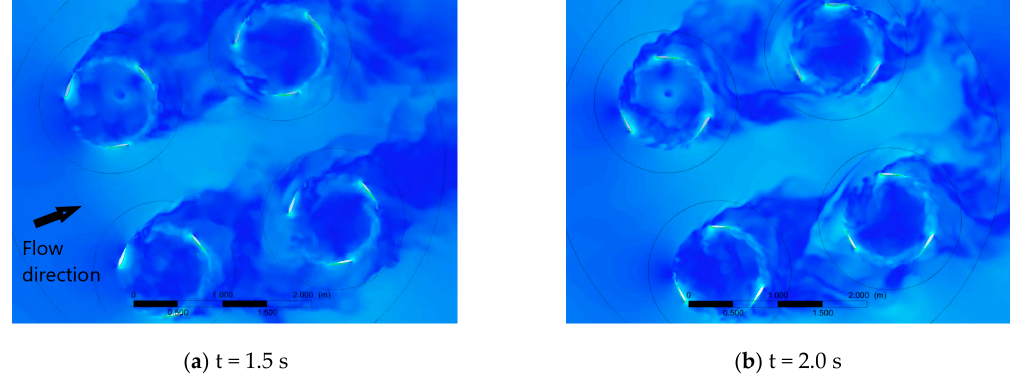
Figure 7. Velocity magnitude flow field for group of VAWTs in close proximity at two instants in time: ( a ) t = 1.5 s and ( b ) 2.0 s.